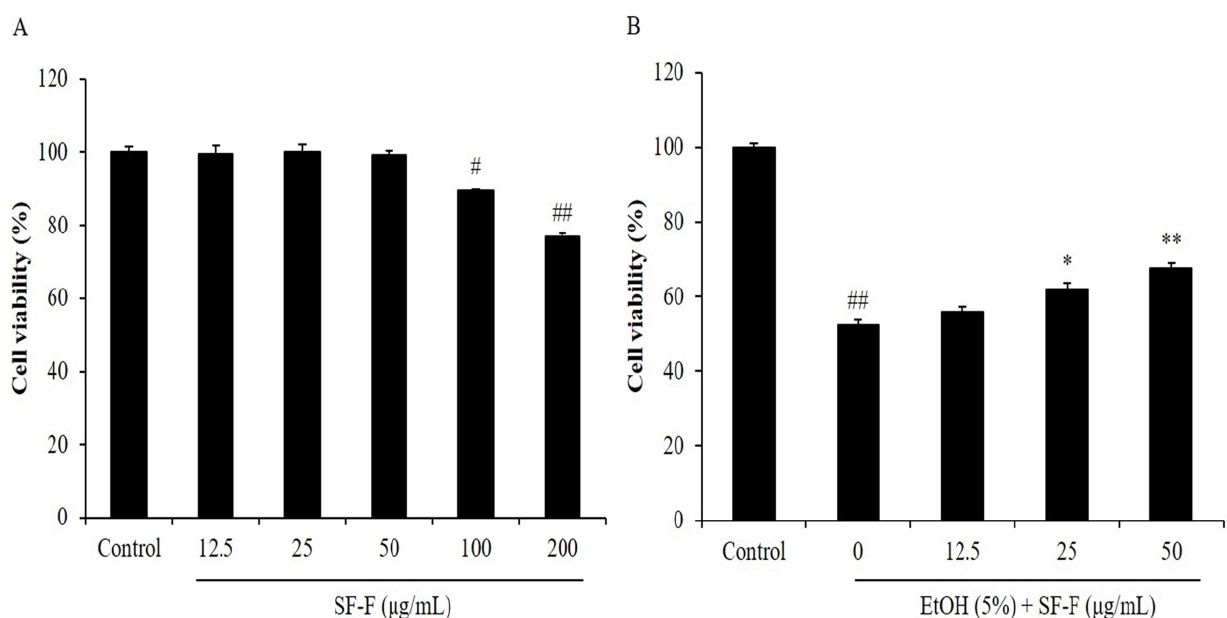
Figure 1. Protective effect of SF-F against EtOH-stimulated Chang liver cells death. ( A ) Cytotoxicity of SF-F on Chang liver cells; ( B ) cytoprotective effect of SF-F in EtOH-stimulated Chang liver cells. Cell viability was measured by MTT assay. The data are expressed as the mean ± SE. * p < 0.05 and ** p < 0.01 as compared to the EtOH-treated group; # p < 0.05 and ## p < 0.01 as compared to the control group.